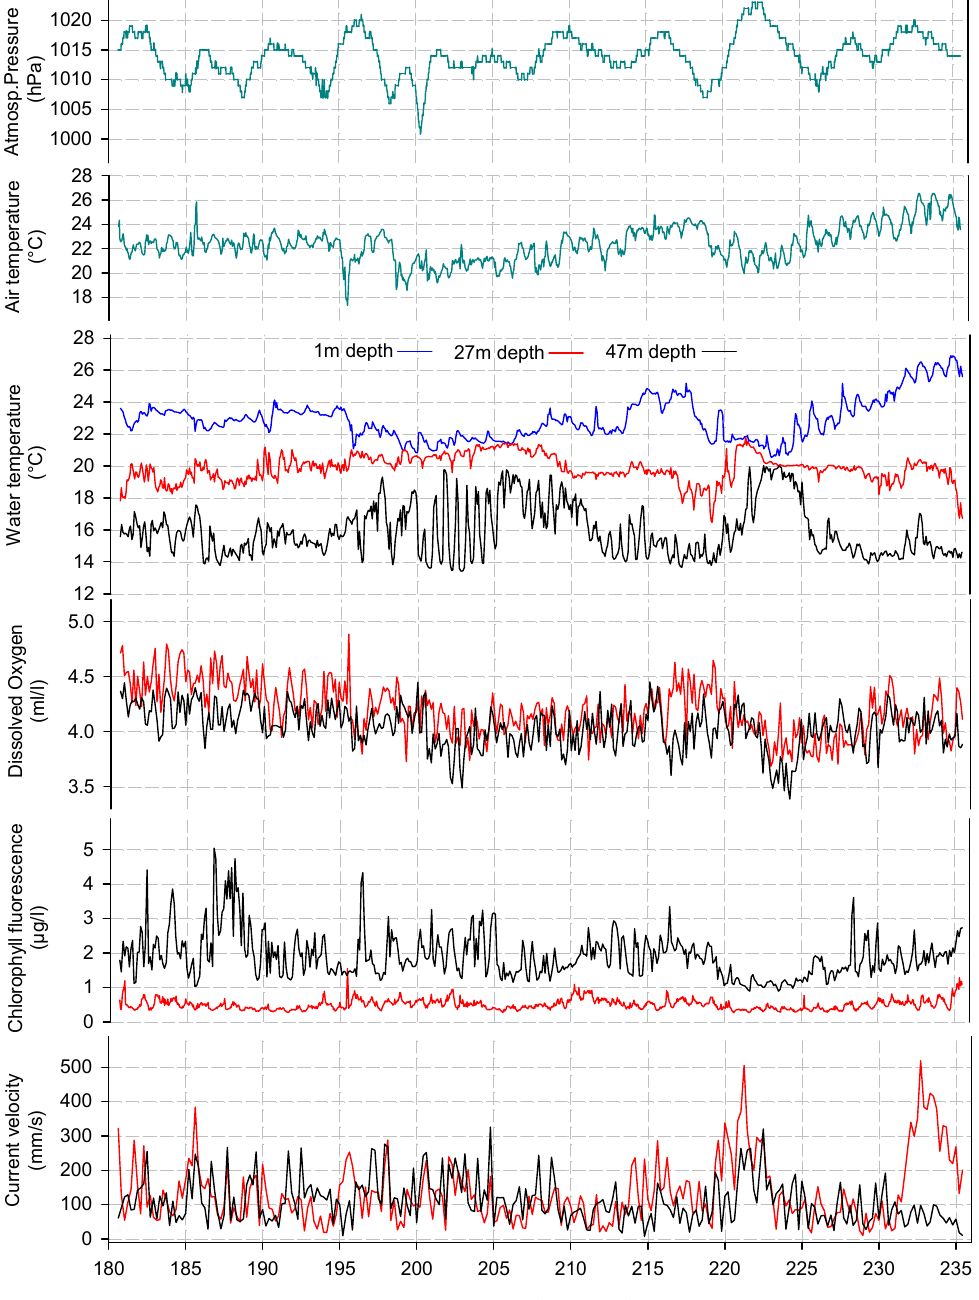
Figure 5. Time series of meteorological and oceanographic observations gathered in summer 2011 ( i.e. , from 30 June to 24 August) at different depths (water surface at 1 m, at 27 m, and finally at 47 m